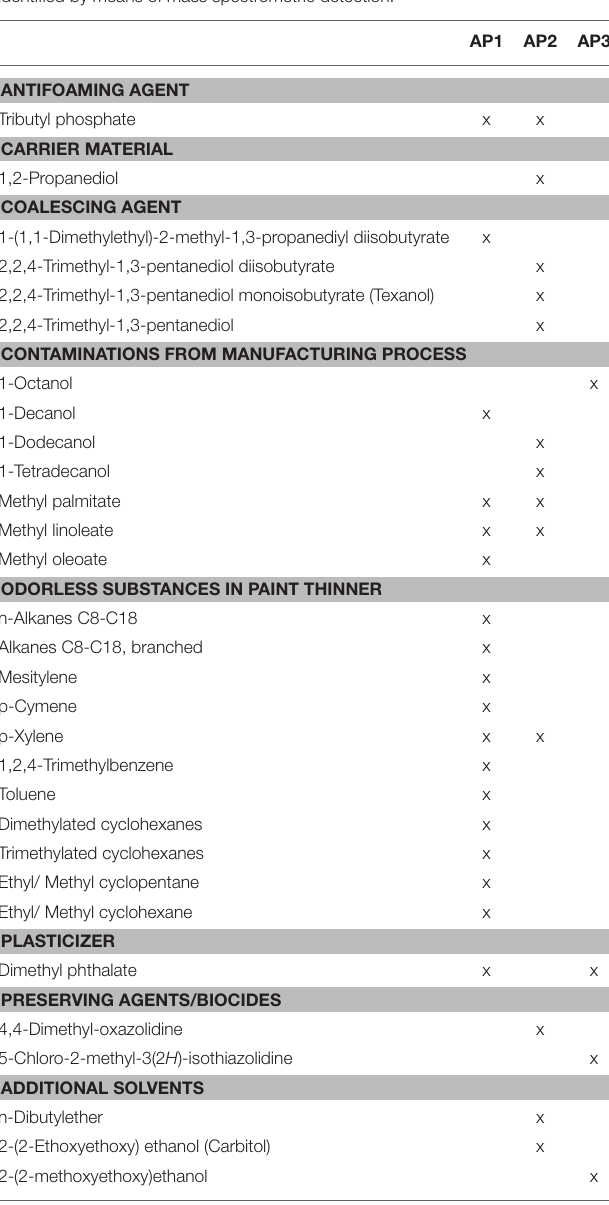
TABLE 3 | Quantitatively dominating and potentially harmful VOCs that were identified by means of mass spectrometric